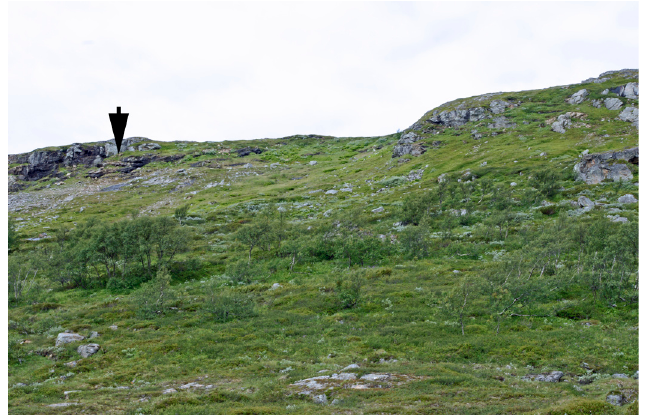
Figure 13: Typically in the advance zone, minor tree stands and copses occur in a mosaic with alpine dwarf-shrub heath. This sub-belt extends just some tens of meters above the old treeline. The new treeline (arrow) has the character of isolated outliers, in this case 140 higher than the treeline in 1915. Mt. Getryggen, 835 m a.s.l. 15 July 2009.